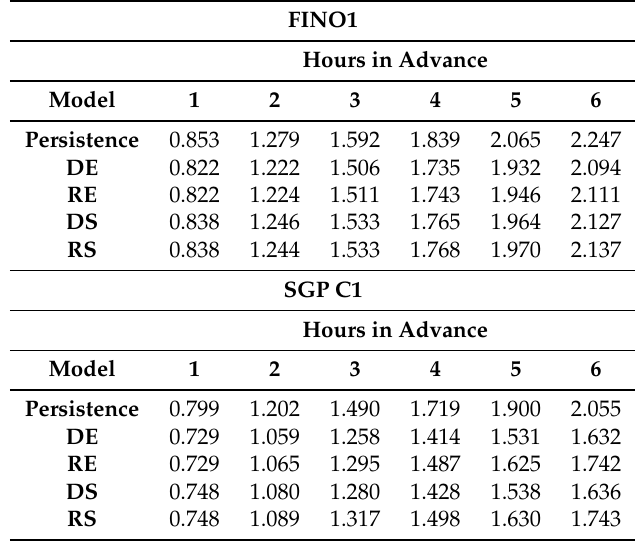
Table A2. RMSE (m s − 1 ) obtained by the four modeling strategies tested as well as the persistence model for hourly forecasts one to six hours in advance.